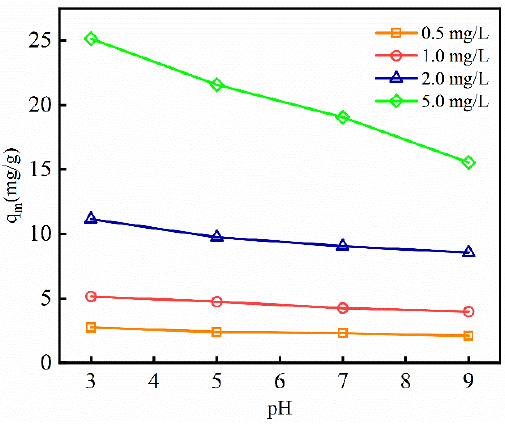
Figure 3. Effect of pH on TCS adsorption by carbon black.